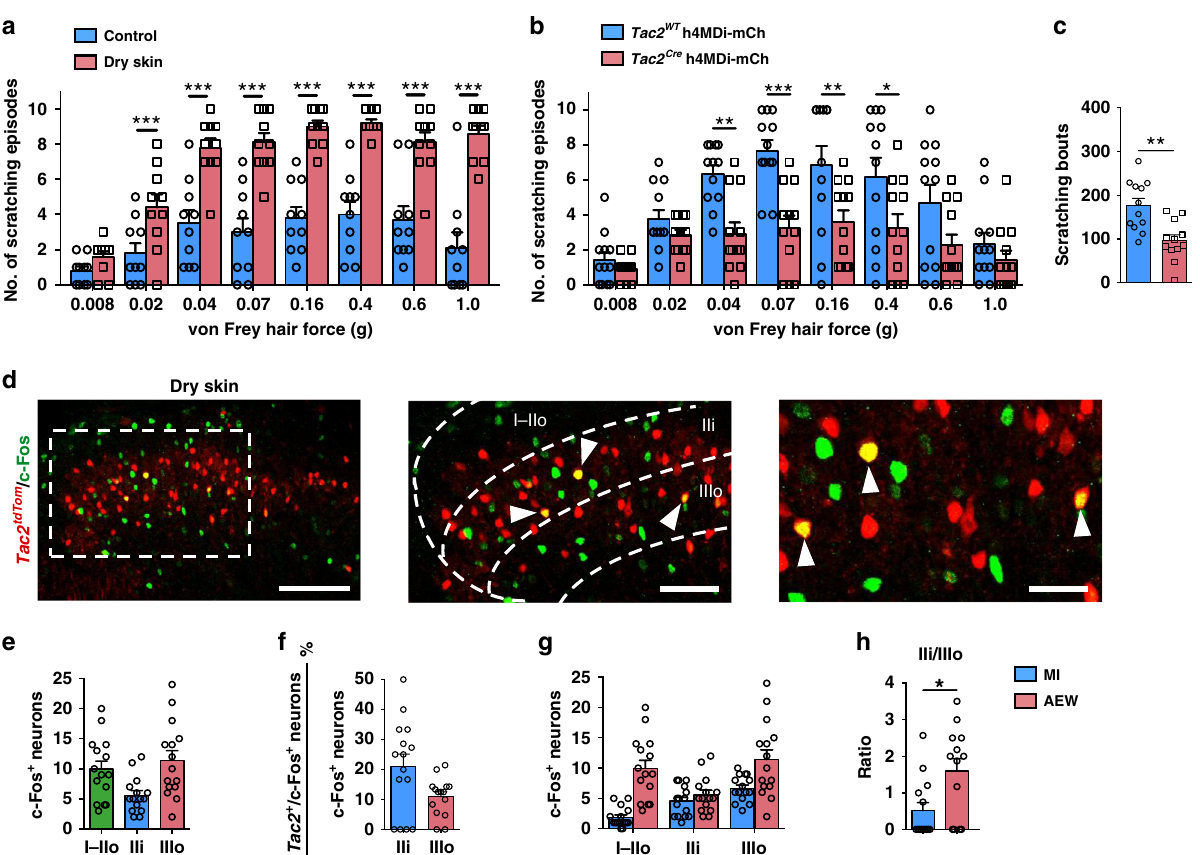
Fig. 7 Tac2 neurons are required for alloknesis and dry skin itch. a Increased mechanical itch in AEW-treated mice relative to the control. Two-way ANOVA with Bonferroni post-hoc . *** p = 0.00001, n = 10 mice per group. b , c Mechanical itch ( b ) and spontaneous scratching behavior ( c ) of AEW- treated mice after chemogenetic inhibition of spinal Tac2 Cre neurons. ( b two-way ANOVA with Bonferroni post-hoc , * p = 0.027, ** p = 0.005 for group 0.04 g, ** p = 0.009 for group 0.16 g, *** p = 0.0001, n = 12 mice per group; c unpaired two-tailed Student ’ s t- test, ** p = 0.001, n = 12 mice per group). d Representative IHC image of c-Fos (green) in the cervical spinal cord of AEW-treated Tac2 tdTom (red) mice. Higher magni fi cation of the boxed area (middle), which is shown at higher magni fi cation (right). Arrowheads indicate double c-Fos + / Tac2 tdTom + neurons. Scale bars, 100 μ m in left of d ; 50 μ m in middle of d ; 25 μ m in right of d . e Quanti fi cation of c-Fos + neurons in laminae I-IIo, IIi and IIIo, respectively. f The ratio of Tac2 tdTom and c-Fos double positive neurons in c-Fos positive neurons in laminae IIi and IIIo. g Comparison of the number of c-Fos + neurons in laminae I-IIo, IIi and IIIo between control mice stimulated by von Frey hair (0.07 g) and AEW mice. h Comparison of the ratio of c-Fos + / Tac2 tdTom + neurons in lamina IIi versus IIIo between control and AEW mice. * p = 0.016, unpaired two-tailed Student ’ s t- test, n = 3 mice per group. All data are presented as means ± s.e.m. and error bars represent s. e.m. Source data are provided as a Source Data fi